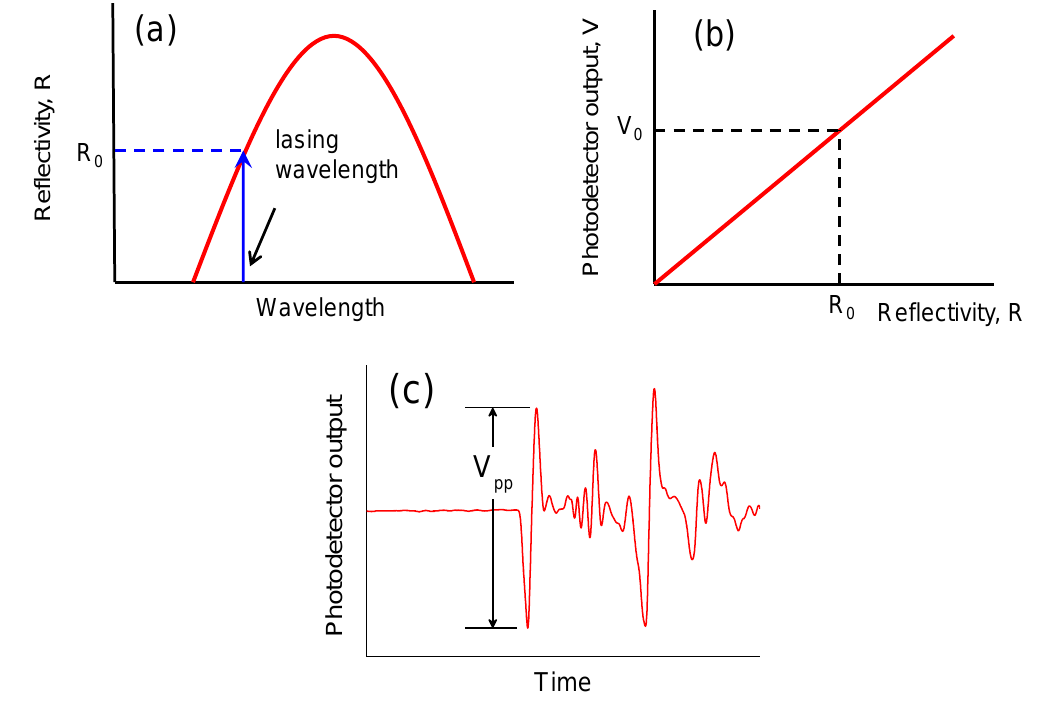
Figure 7. Schematics illustrating the evaluation of strain induced by an ultrasonic vibration. (a) The reflection spectrum of an FBG sensor. (b) The relation between the photodetector output and the reflectivity of the FBG sensor at the lasing wavelength. (c) An example of an obtained photodetector output signal.